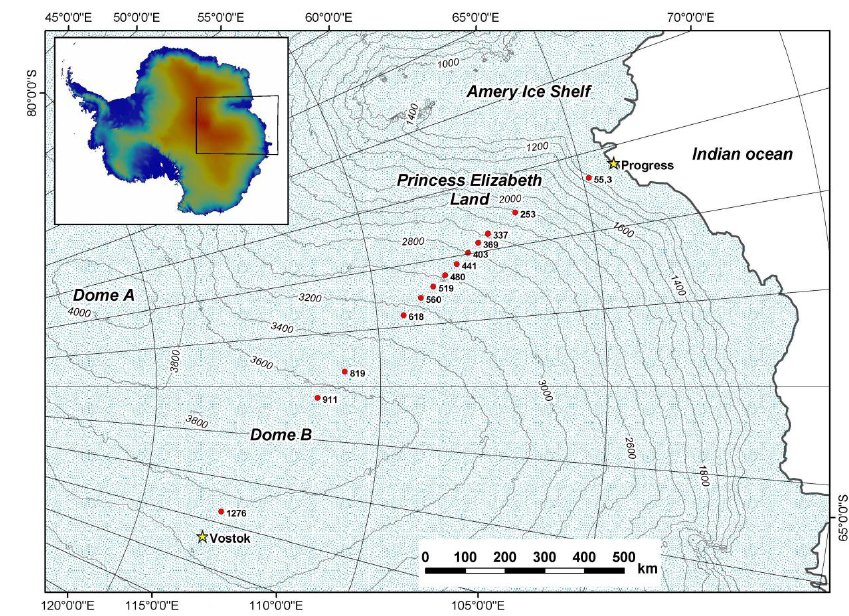
Fig. 1. A map of sampling sites (red circles with labelled distances in km) along the traverse between the Progress and Vostok stations (yellow stars). Topographic contours of > 1000ma.s.l. are